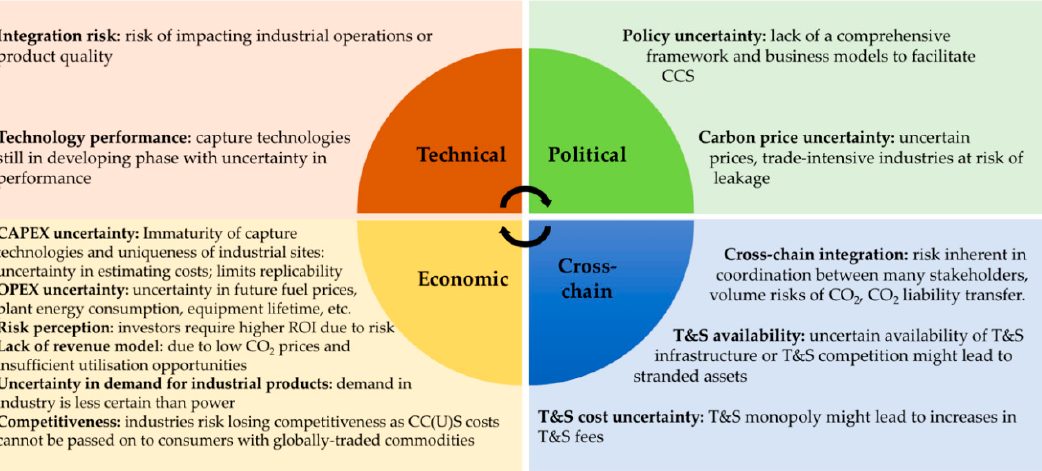
Figure 3. Key challenges of implementing industrial CCUS.